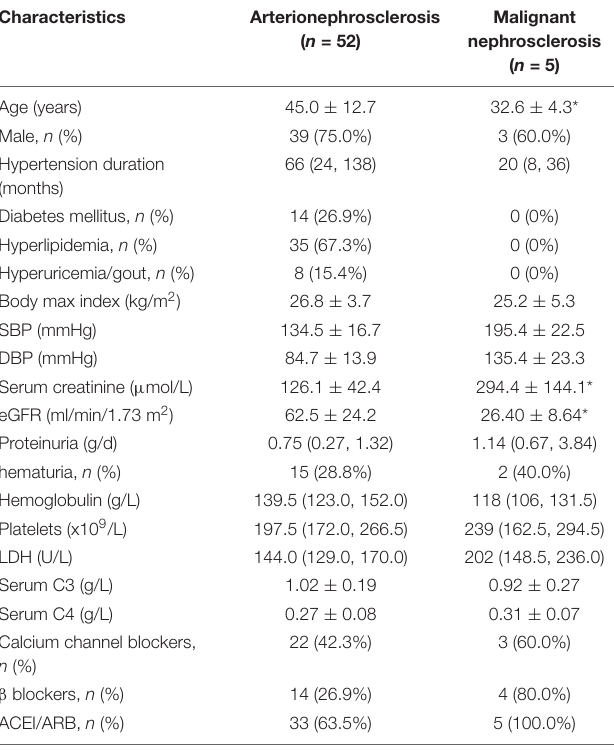
TABLE 1 | Clinical features of subjects with arterionephrosclerosis and malignant nephrosclerosis.